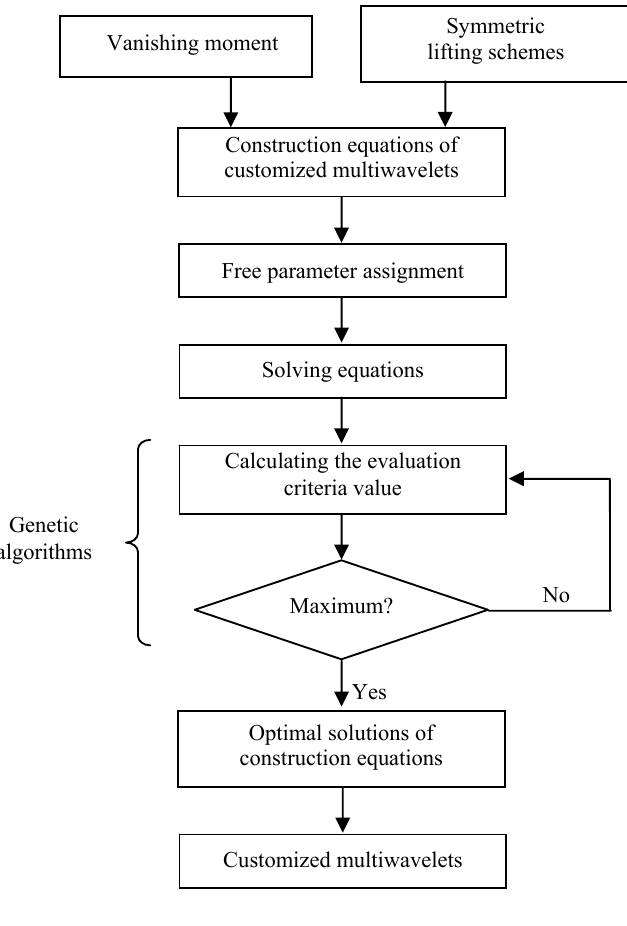
Figure 7. The flow chart of the customized